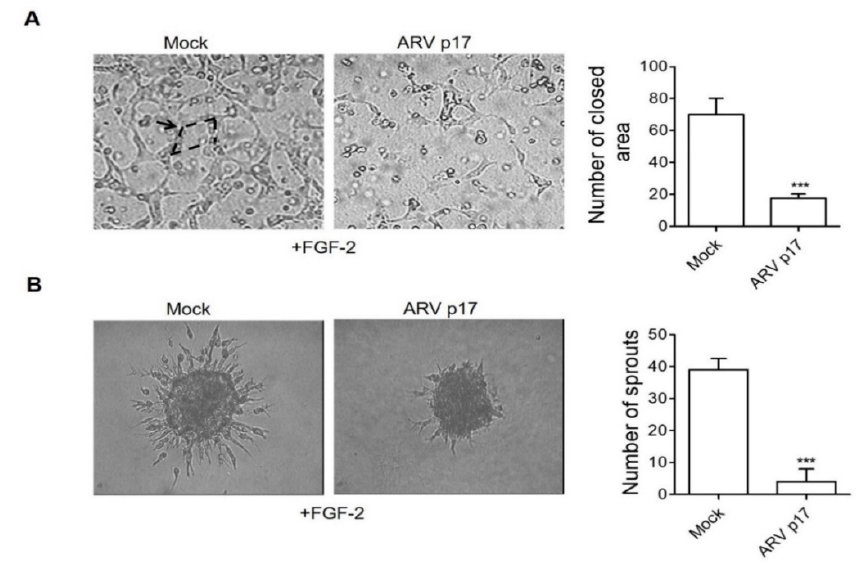
Figure 3. ARV p17 inhibits ECs angiogenesis. HUVEC cells were mock-nucleofected (Mock) or nucleofected with ARV p17-expressing plasmid (ARV p17). Angiogenesis was analyzed 48 h post- nucleofection. ( A ) Tube formation of Mock or ARV p17 HUVECs along with FGF-2 treatment in a three-dimensional (3D) Matrigel culture. Lined by the tubes, the closed areas (an example indicated by the arrow) were counted as a parameter for quantification of tube formation. Pictures were taken after 24 h of culture (original magnification, 10 × ). Pictures are representative of one out of three independent experiments with similar results. Values are the mean ± SD of one representative experiment out of three with similar results, performed in triplicates. Statistical analysis was performed by Student’s t test. *** p < 0.001. ( B ) Sprouting of spheroids generated by Mock or ARV p17 HUVECs upon FGF-2 treatment. Pictures were taken after 24 h of culture (original magnification, 20 × ). The bar graph shows the average number/spheroid of EC sprouts. Pictures are representative of one out of three independent experiments with similar results. Values are the mean ± SD of one representative experiment out of three with similar results, performed in